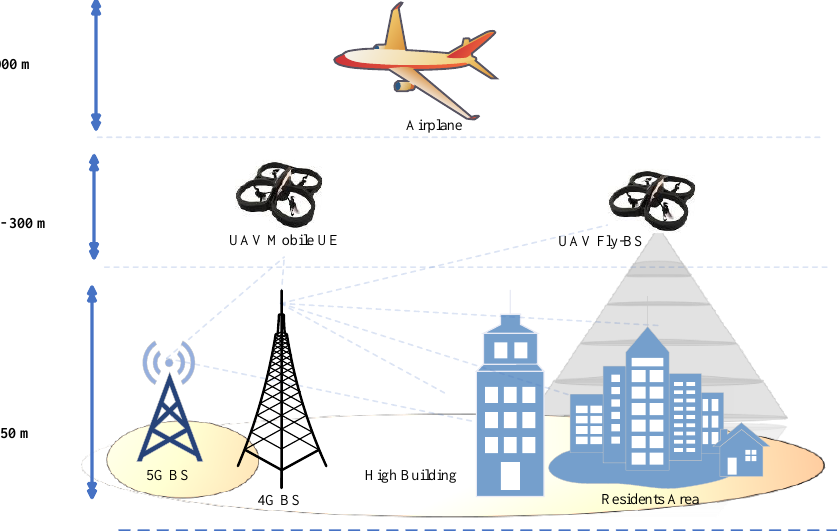
Figure 2. UAV base station (UBS) and normal BSs in a future ultra–dens heterogenous network.